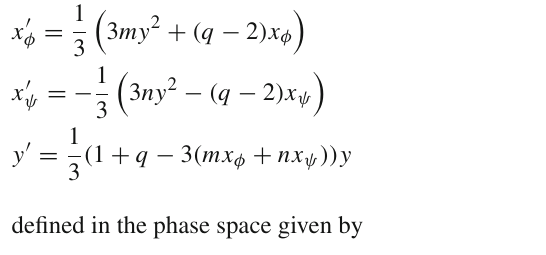
represents the physical portion of the phase plane which is either half ellipse or half